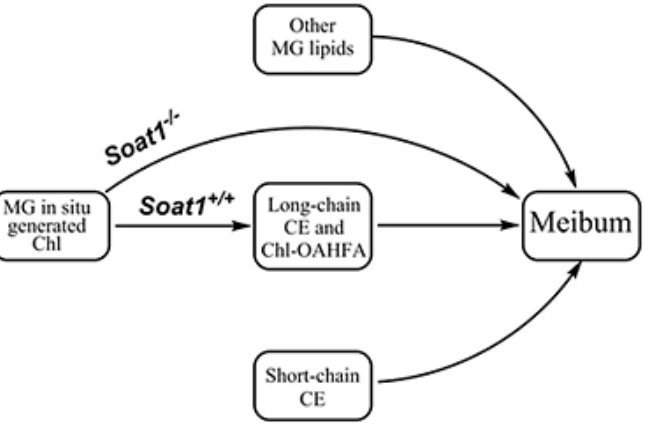
Figure 9. Role of Soat1 in the biosynthesis of cholesteryl esters in Meibomian